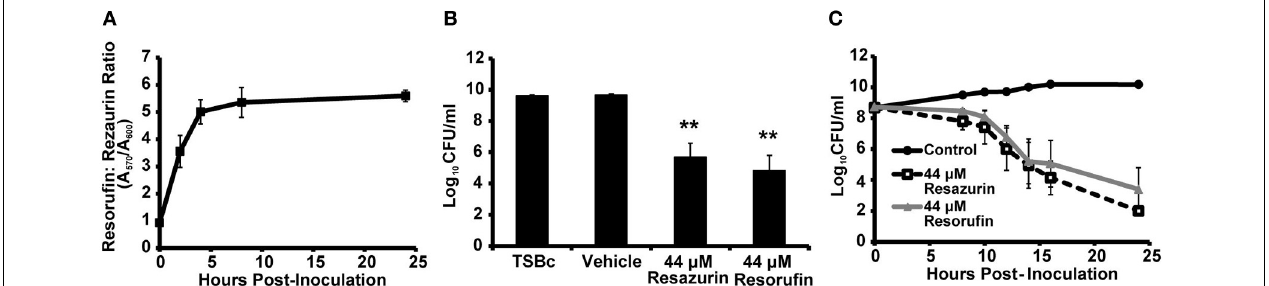
FIGURE 3 | F. tularensis LVS reduces resazurin to resorufin which also inhibits bacterial growth. F. tularensis LVS bacteria were cultivated in TSBc that was treated with resazurin, resorufin, or the solvent vehicle (DMSO). (A) Conversion of resazurin (absorbance at 600nm) to resorufin (absorbance at 570nm) in F. tularensis LVS cultures over 24h. (B,C) F. tularensis LVS cultures weredilutedandplatedtodeterminethenumberofviablebacteriaat24h (B) or